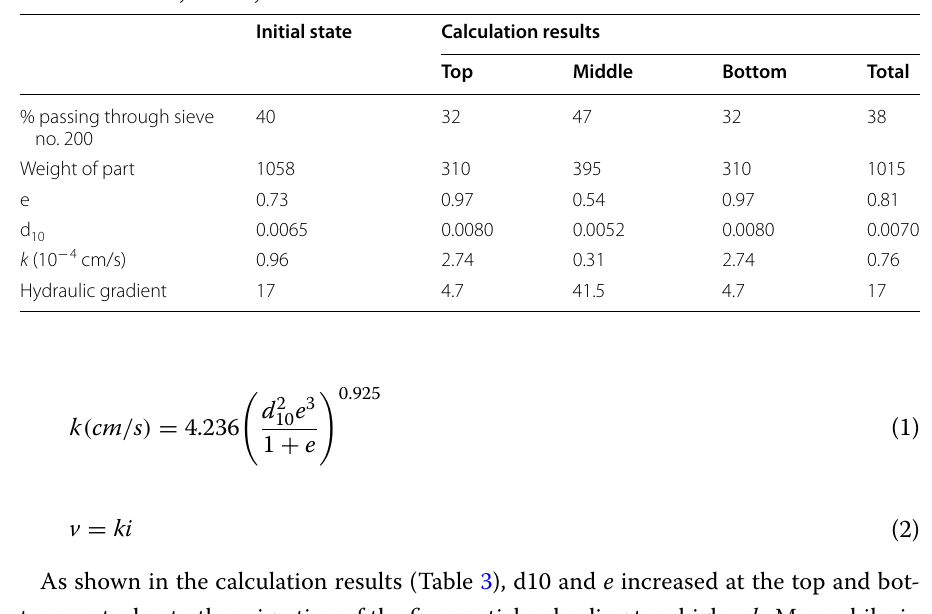
Table 3 Summary of analysis